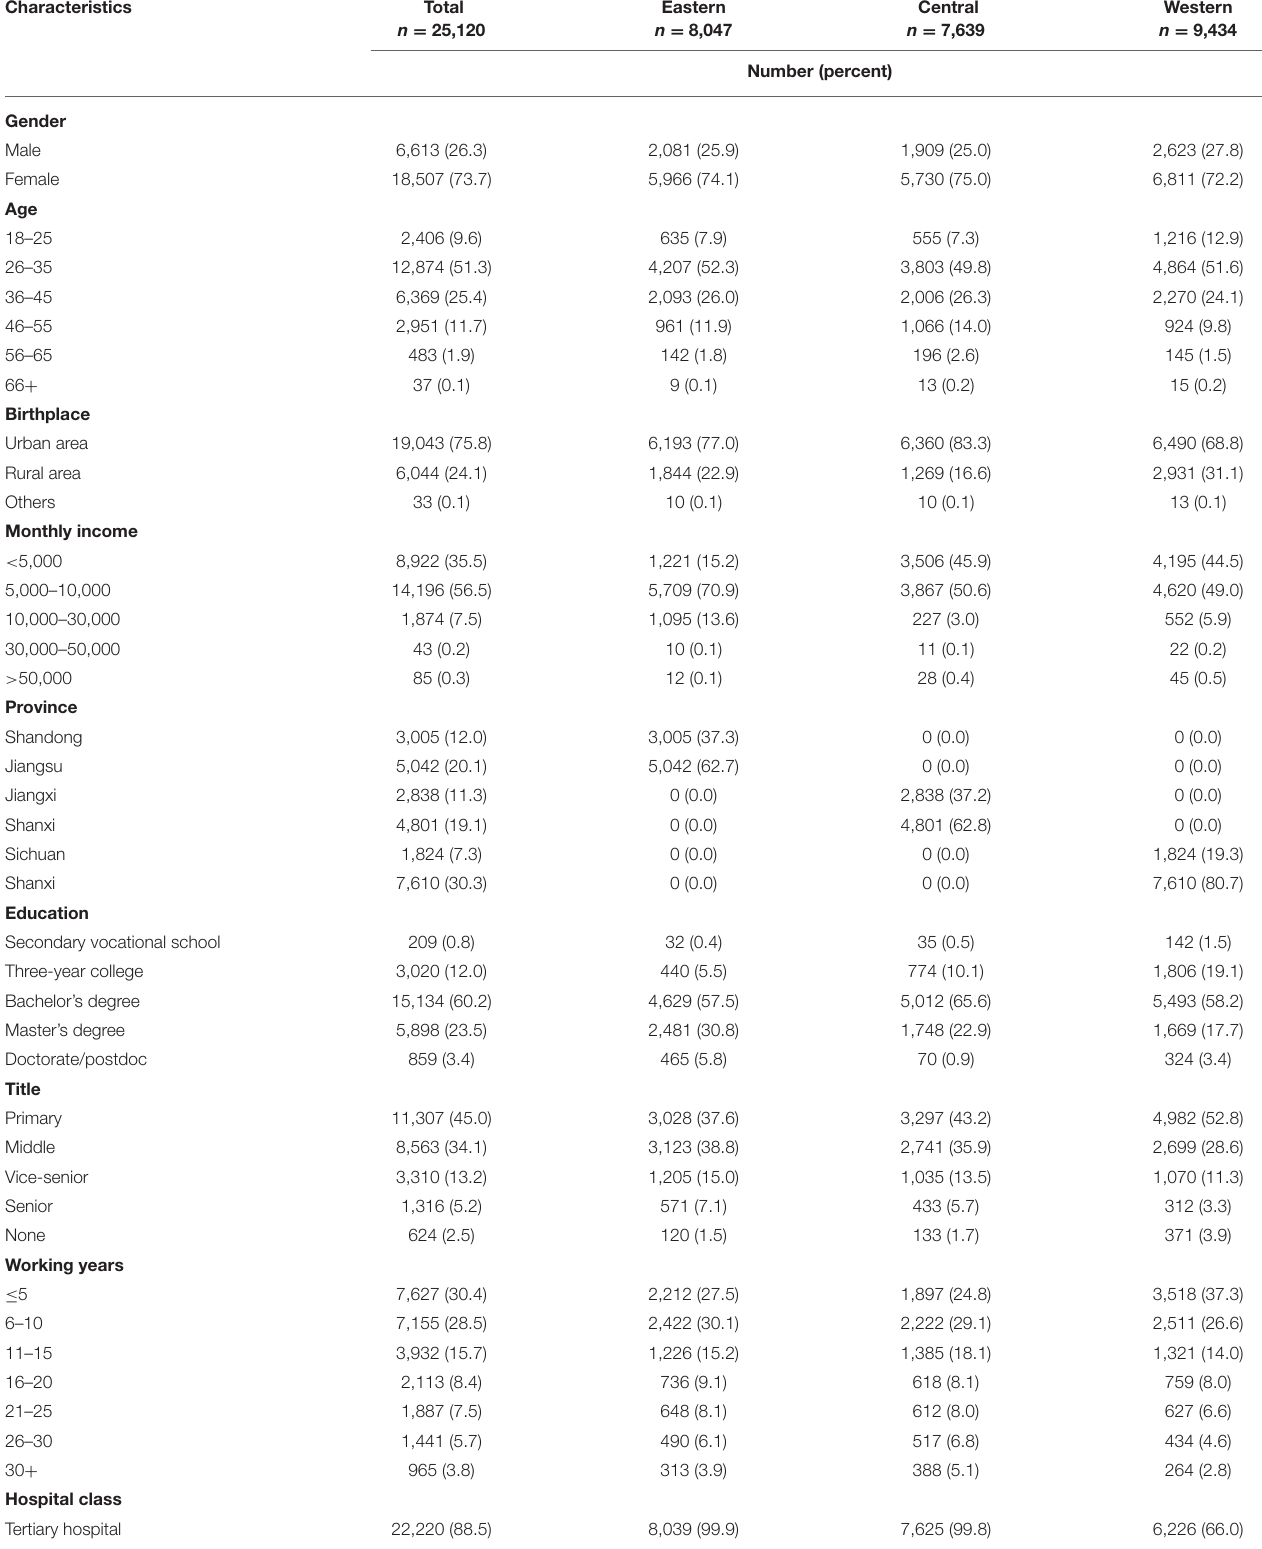
TABLE 1 | Demographic characteristics of medical professionals in China.